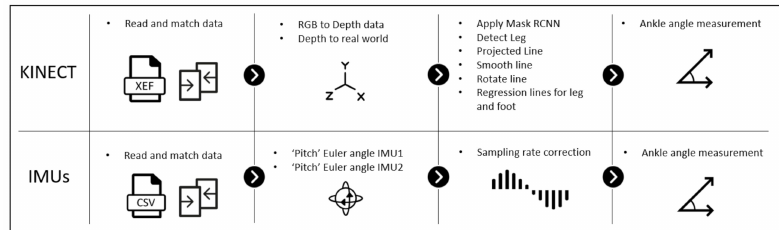
Figure 5. Steps to follow from reading the raw data to measuring the